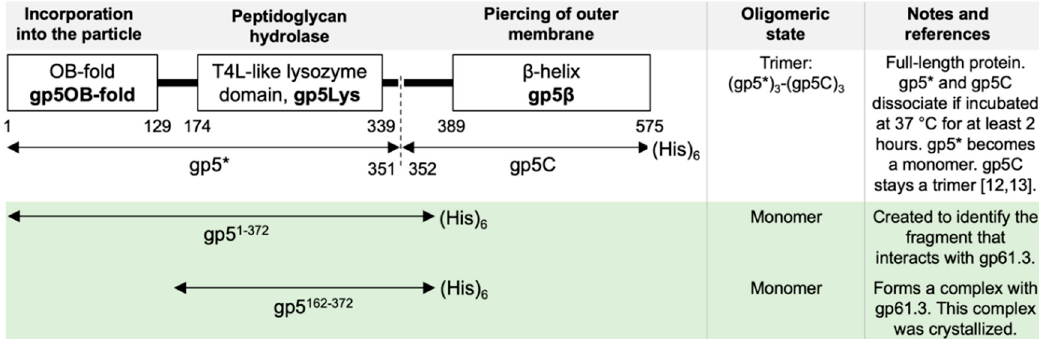
Figure 1. Domain organization of gp5, fragments used in the study, their properties, and additional